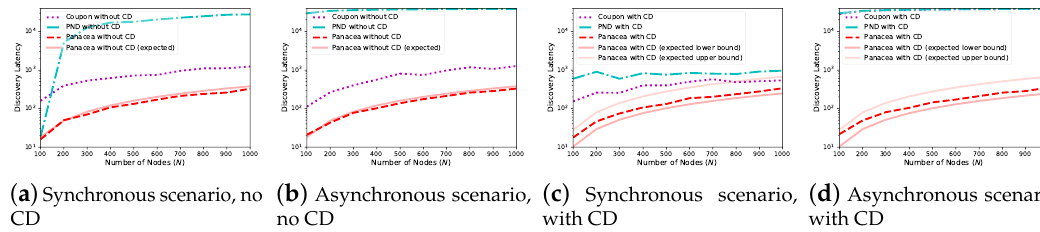
Figure 5. Panacea -NCD and Panacea -WCD achieve the lowest discovery latency for both synchronous and asynchronous scenarios under the uniform distribution.